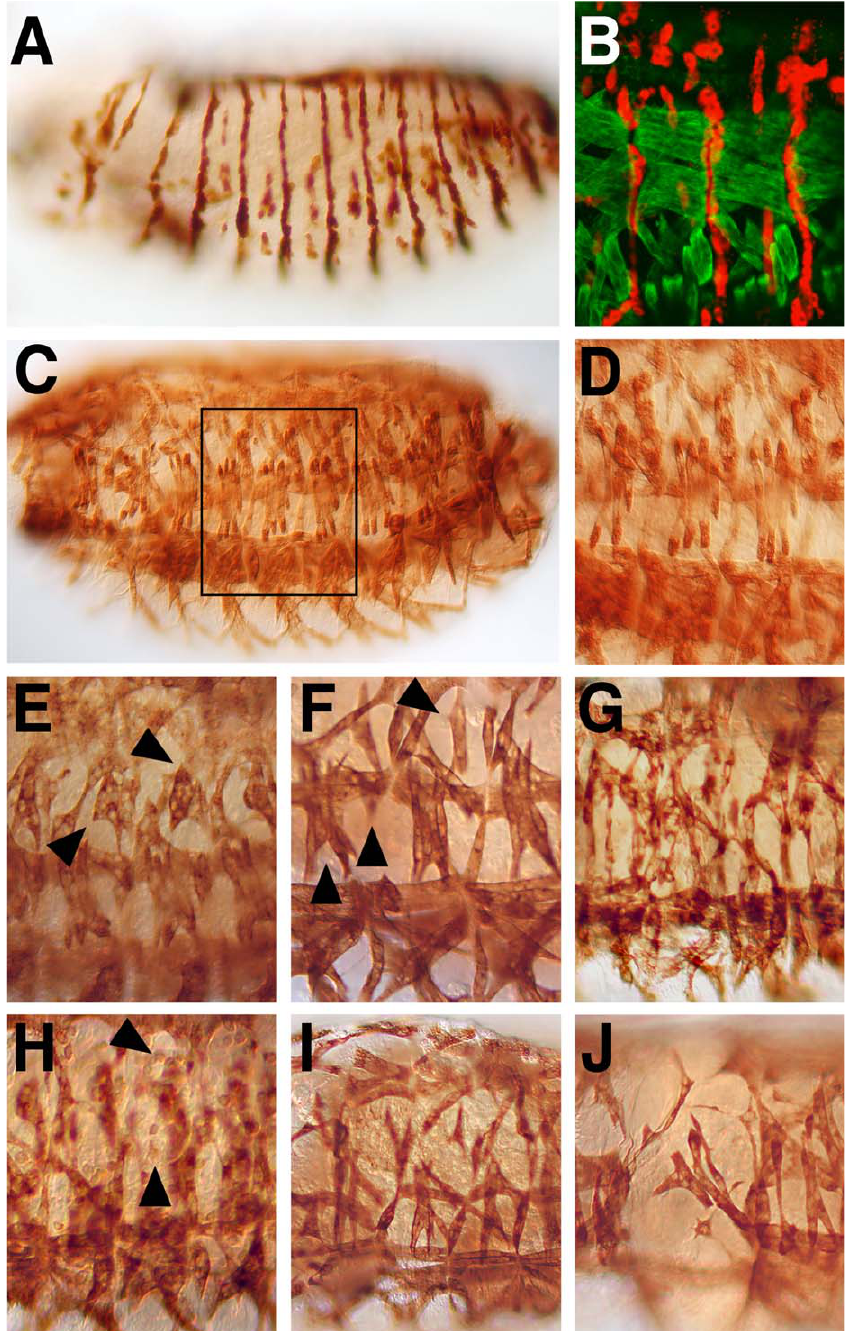
Figure 1. Expression Pattern of the srmodGAL4 -Driver and Induced Muscle Pattern Defects in Response to EP Targeted Endogenous D. melanogaster Genes (A) Expression pattern of srmodGAL4 driving a UAS- lacZ transgene in a stage 15 embryo (lateral view). Note the expression of b -Galactosidase in a segmentally repeated pattern of segment border cells, which appear as stripes, and in an array of partially interrupted intersegmental cell rows between them. (B) Enlarged lateral area of a stage 16 embryo stained with anti-MHC antibodies (green) to visualize the muscle pattern and anti- b -Galactosidase antibodies (red) to visualize the apodemes and intrasegmental epidermal cells that express the marker gene in response to srmodGAL4 activity (red). (C and D) Muscle pattern (anti-MHC staining) of wild-type stage 16 embryos (C) and enlarged lateral area (D) outlined in (C). (E–J) Examples of muscle phenotypes (enlargements as in [D]) in response to srmodGAL4 -driven misexpression of EP-targeted genes. Note that expression of CG9742 (HD10913) induces abnormal attachment of LT4 and LT5 muscles ([E], arrowheads), adk1 (HD32155) affects the shape and attachment of all LT muscles ([F], arrowheads), parg (HD10914) causes an abnormal shape and attachment of all lateral muscles (G), and CG32436 (HD35012) impairs the fusion of myoblasts (see unfused MHC-stained myoblasts) ([H], arrowheads), whereas CG4963 (HD35059) (I) and CG31710 (EP2160) (J) affect determination, growth, and attachment of many muscles at the same time. DOI: